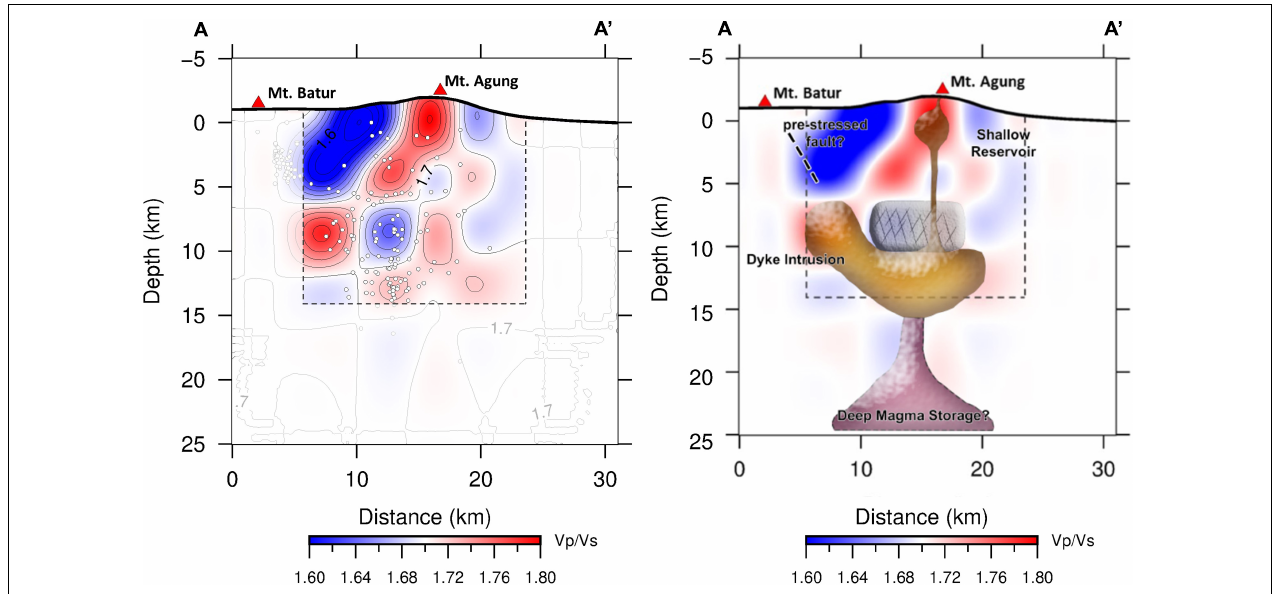
FIGURE 5 | (A) Vp/Vs vertical cross-sections along section A-A’ , This image description is the same as in Figure 3 with the addition of the Vp/Vs contour. (B) The schematic diagram for interpretation of the results along section A-A’ is derived from the Vp/Vs ratio structure. Dyke intrusion penetrated upward toward the west-northwest of Mt. Agung. Based on the resolution test results, we define well-resolved regions inside dashed black lines.